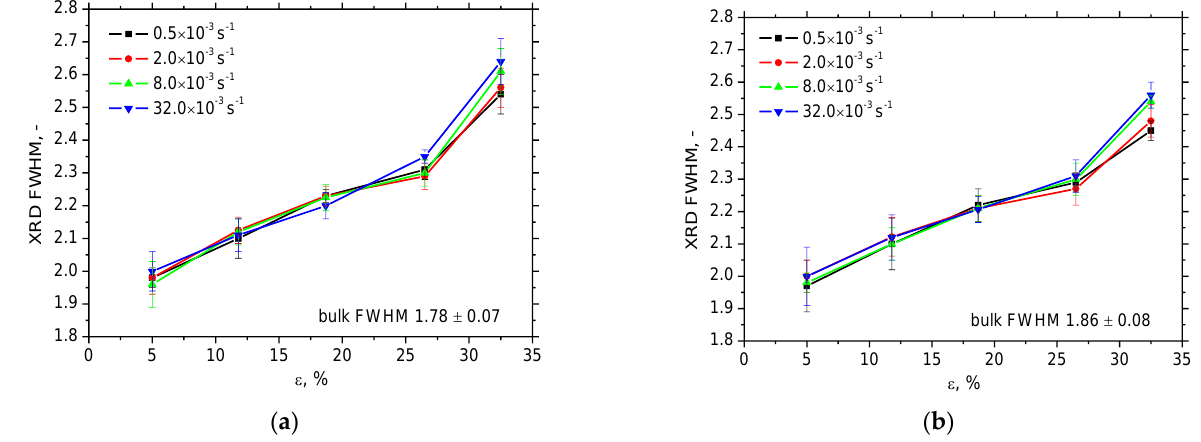
Figure 9. Evolution of XRD FWHM as a function of plastic strain and strain rate. ( a ) RD, ( b )